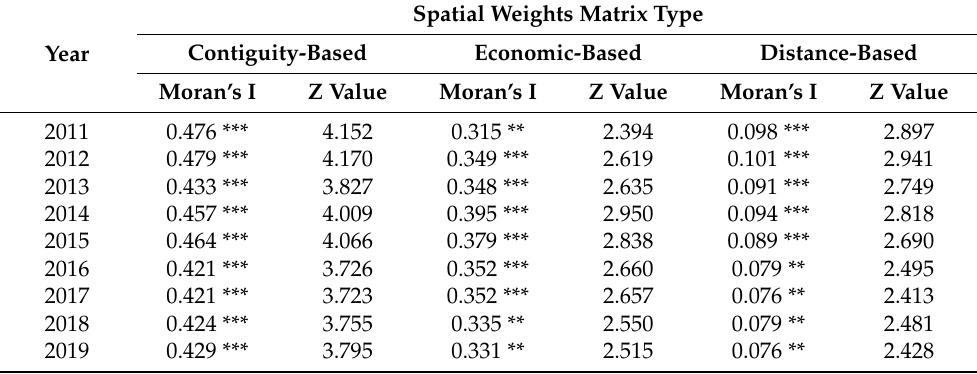
Table 9. The spatial correlation test results.